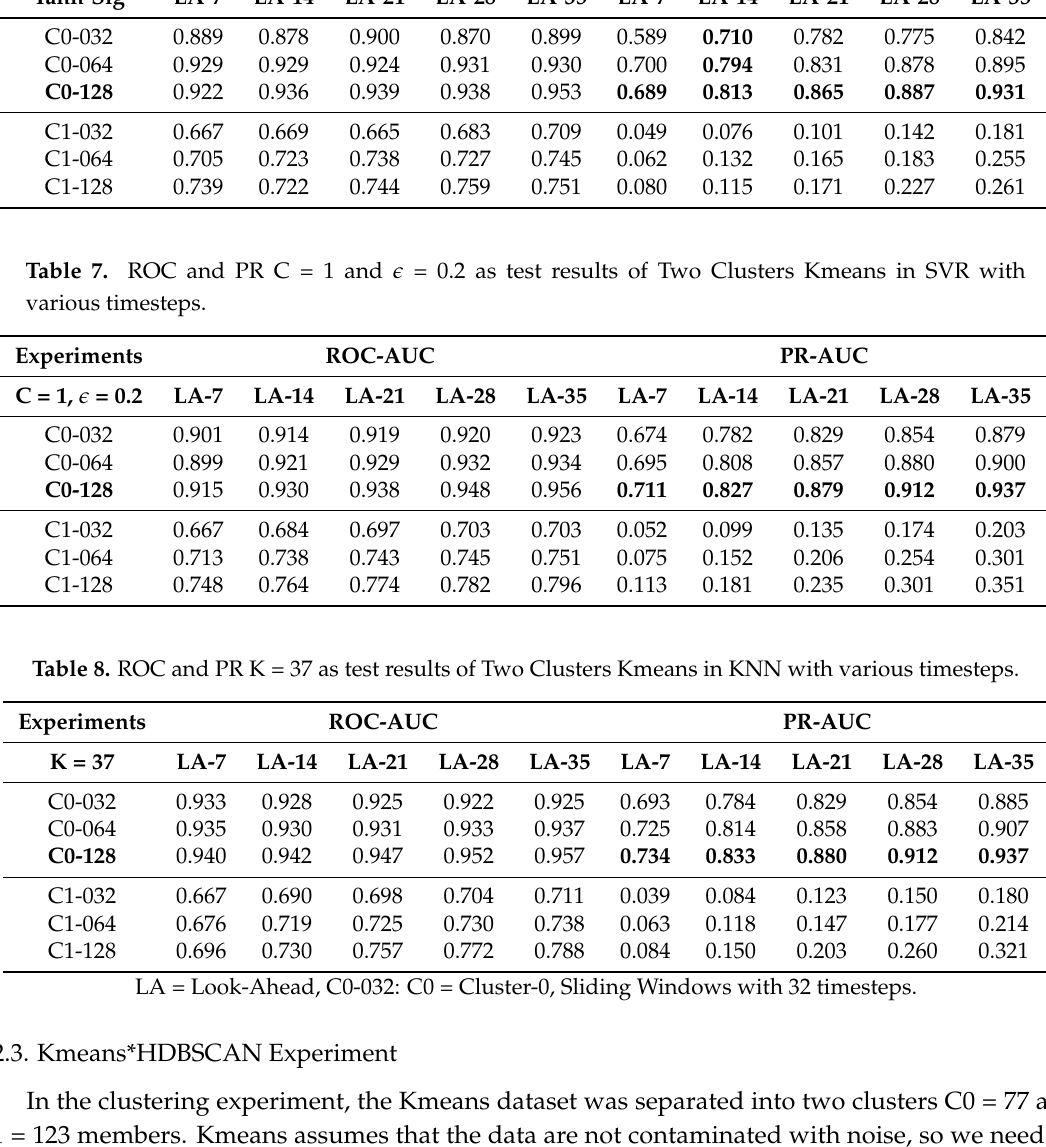
Table 6. ROC-AUC and PR-AUC as test results of Two Clusters Kmeans in DNN with various timesteps. Experiments